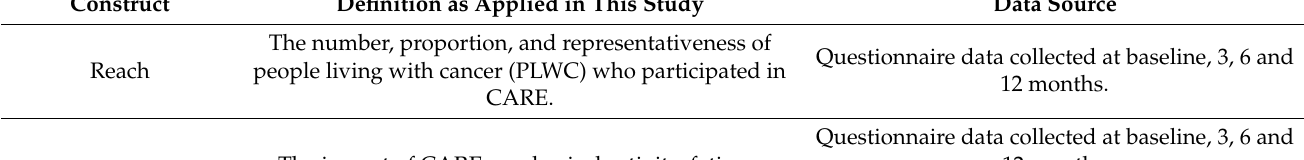
Table 1. Components of the RE-AIM framework in the context of Cancer and Rehabilitation Exercise (CARE).